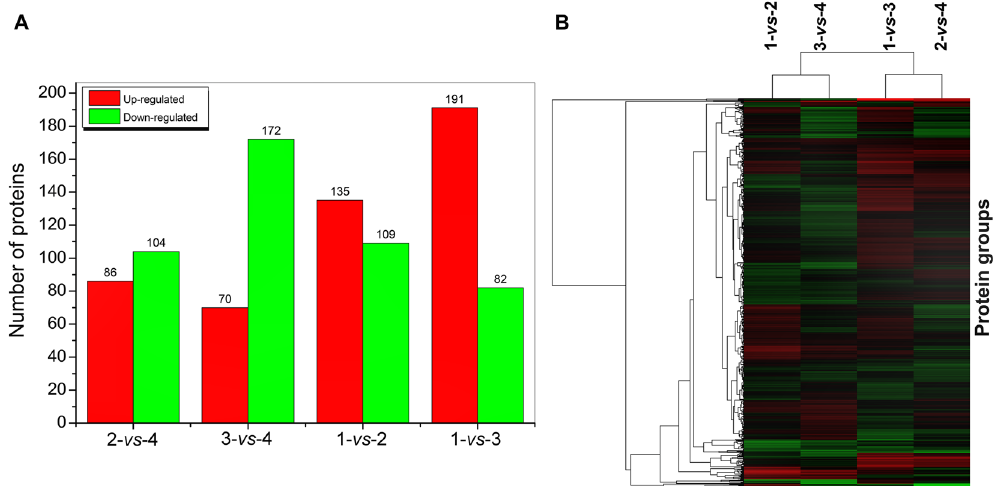
Figure 2. Differential protein expression and their cluster analysis of four sample pairwise comparisons. ( A ) The red and green coloured columns represent up- and down-regulated proteins, and the corresponding number of differentially expressed proteins is indicated. ( B ) The changing profiles of proteins that were differentially expressed more than 1.2-fold in any one comparison were hierarchically clustered. Different colours represent different expression folds of the proteins. Decreased and increased abundances are indicated by green and red shading, respectively. Each protein group (one per line) is shown along the y-axis, and the comparison groups are shown on the x-axis. Four sample pairwise comparisons were as follows: 1- vs -2, 12 h with 0 mM versus 1 mM Mn(II); 3- vs -4, 48 h with 0 mM versus 1 mM Mn(II); 1- vs -3, 12 h versus 48 h with 0 mM Mn(II); and 2- vs -4, 12 h versus 48 h with 1 mM